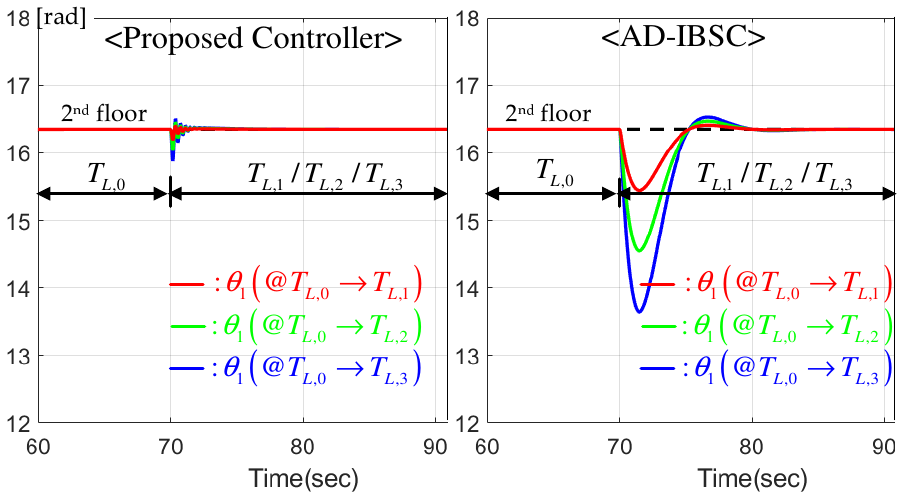
Figure 8. Position response comparison (master motor) for different load variations.